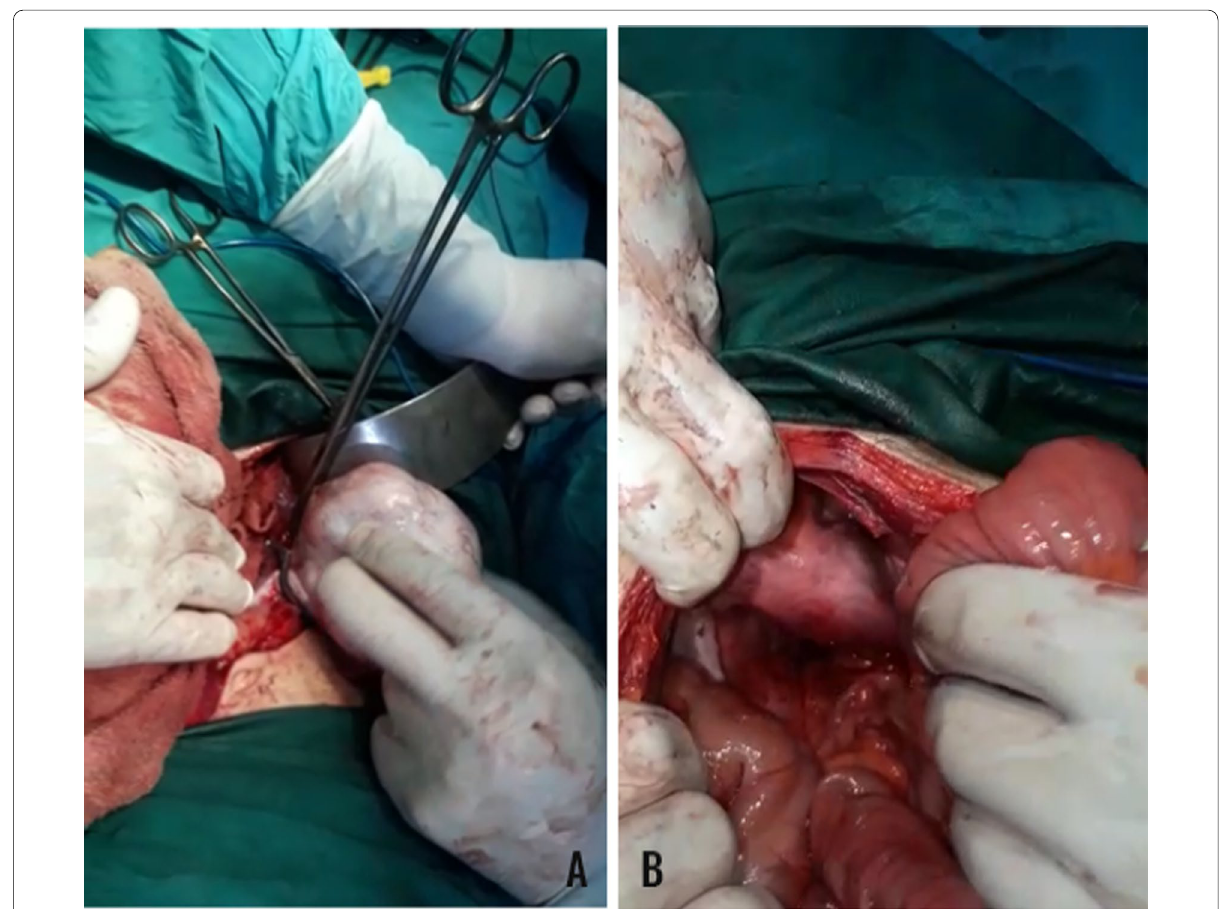
Fig.2 A Pelvic cyst mass in the Iliac fossa and B uterus found during the laparotomy